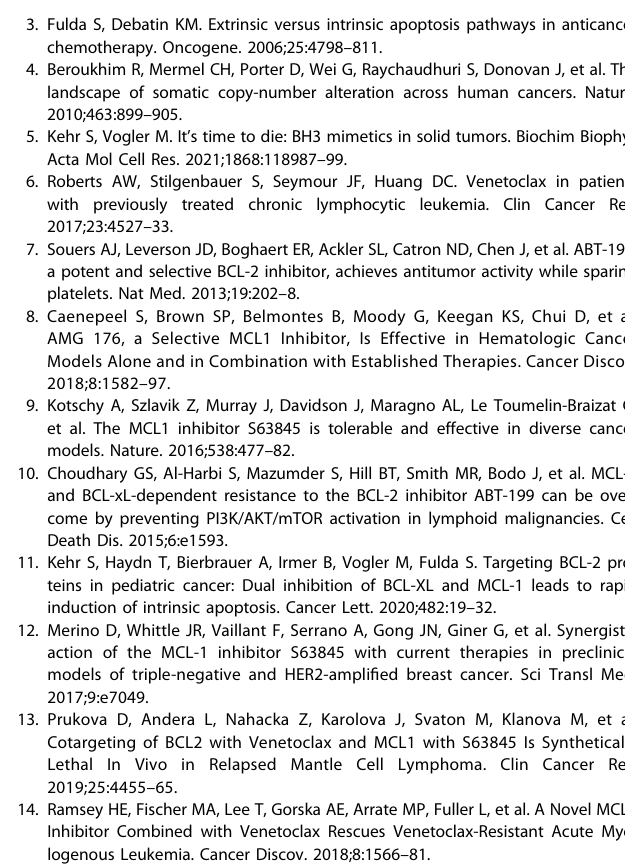
Fig. 7 Caspase dependency of BH3 mimetic sensitization towards NK cell killing. A RH30 and RD wild-type spheroids were pretreated with either S63845 (0.3 μ M) or A1331852 (0.3 μ M) for 4 h, before addition of NK cells. After 24 h of NK cell co-cultivation, caspase activity was stained using a CellEvent ™ Caspase 3/7 green detection substrate. TL: transmitted light channel. B To inhibit caspase activity or TRAIL, GFP expressing RMS spheroids were co-cultured with zVAD.fmk (50 μ M) or anti-TRAIL blocking antibody (1 μ g/ml) in combination with BH3 mimetics for 4 h before addition of NK cells (E:T ratio of 1:1). To visualize cell death, spheroids were counterstained with PI after 72 h of NK cell co-culture. Data shown are mean + S.D. ( n = 3). Scale bar equals to 500 μ